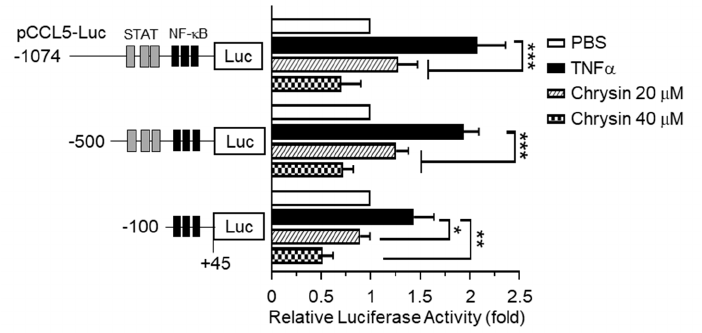
Figure 2. E ff ect of chrysin on the inhibition of TNF α -induced CCL5 promoter activity. HaCaT